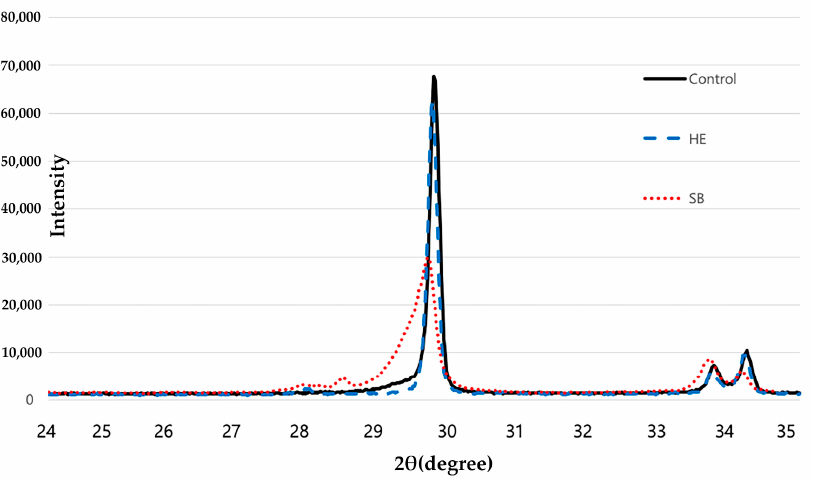
Figure 5. X-ray diffraction patterns of control (CT), sandblasting (SB), and hot-etching (HE)